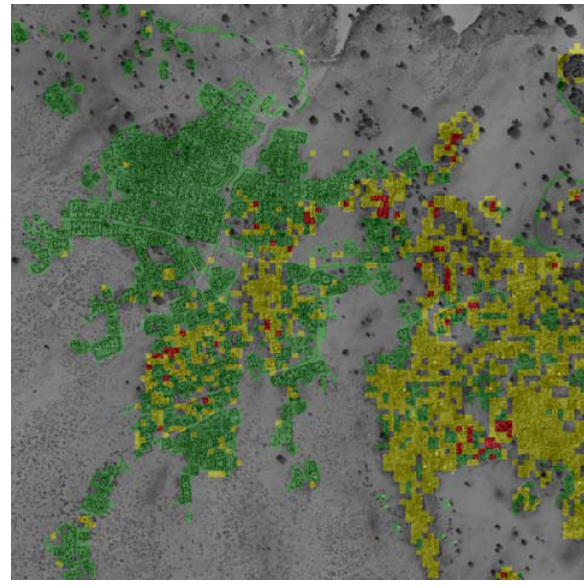
Fig. 8 Change map of Abu Suruj: new buildings (green), low to moderate change (yellow), extensive change